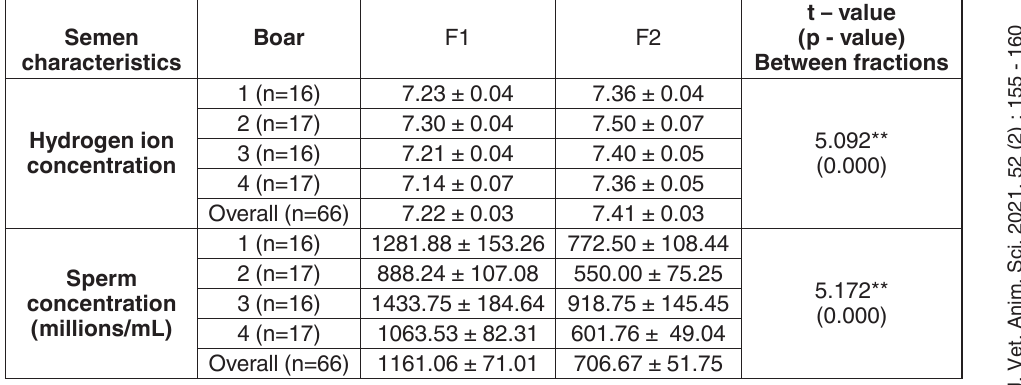
Table 2. Hydrogen ion concentration and sperm concentration (Mean ± SE) in different fractions of Large white Yorkshire boar fresh semen